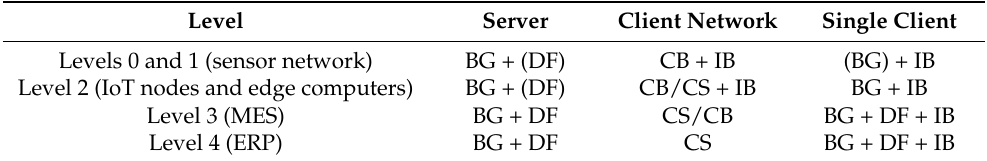
Table 5. Elements of the deployment strategy used in various levels (BG—blue/green, DF—dark mode with feature flags, CS—canary with sentinel node, CB—canary with backup node, IB— intermediate buffer, (XX)—optionally). Level Server Client Network Single Client Levels 0 and 1 (sensor network) BG + (DF) CB + IB (BG) + IB Level 2 (IoT nodes and edge computers) BG + (DF) CB/CS + IB Level 3 (MES) CS/CB Level 4